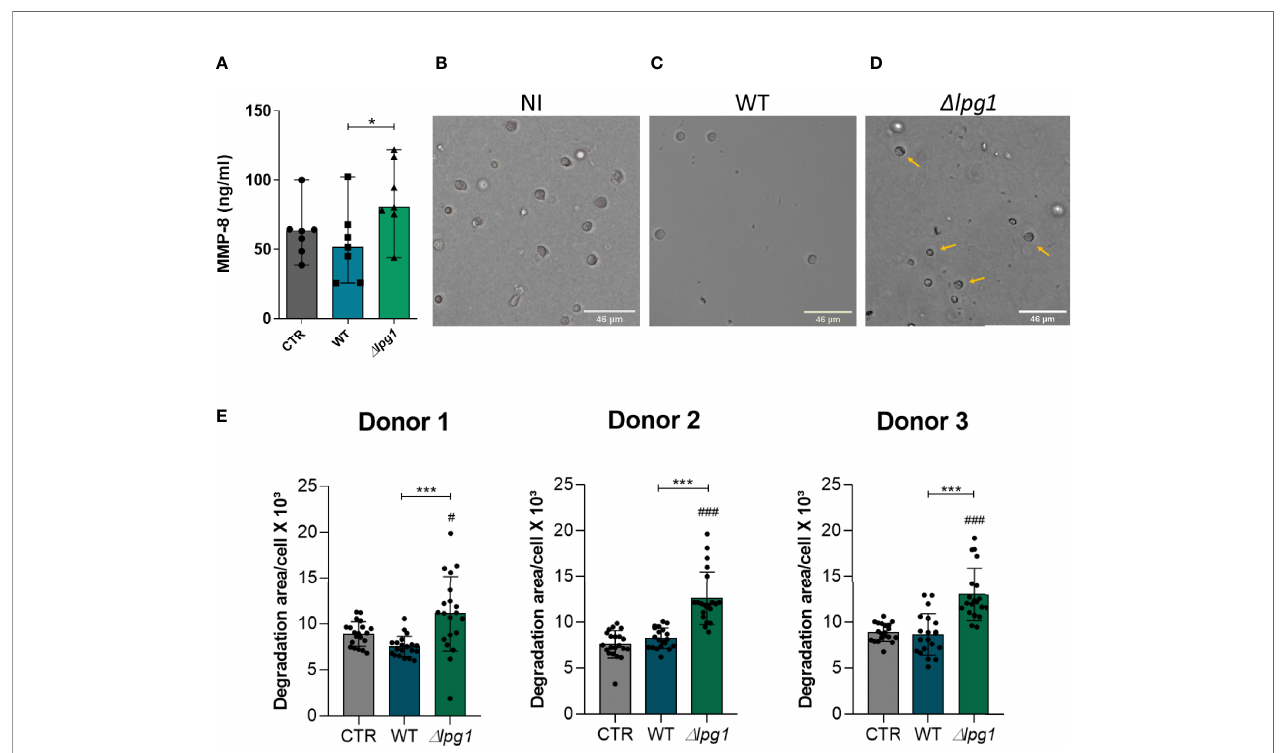
FIGURE 3 | Infection with L. infantum Δ lpg1 triggers secretion of MMP-8 and extracellular matrix type-I collagen degradation. Human neutrophils were infected with L. infantum WT or Δ lpg1 for 3 h Concentrations of MMP-8 in cell supernatants were quanti fi ed by ELISA and compared between the groups (A) . Representative images of collagen I matrix degradation by human neutrophils in the following conditions: non-infected (B) , infected with WT (C) , or infected with Δ lpg1 L. infantum (D) . Pictures were obtained using an inverted microscope. Quanti fi cation of collagen I matrix degradation was performed using the FIJI program, from 20 to 25 cells per group, which are represented by the points on the graph; data from three distinct experiments using cells from different donors are shown (E) . In (A) Asterisk indicate signi fi cant differences examined using the nonparametric Mann – Whitney U test (*p < 0.05,). In (E) Asterisks indicate statistically signi fi cant differences assessed by the non-parametric Kruskal – Wallis test with Dunn ’ s multiple comparisons ad hoc test (***p < 0.001).Differences between experimental group and control are indicated with hashtags ( # p < 0.05) and ( ### p <